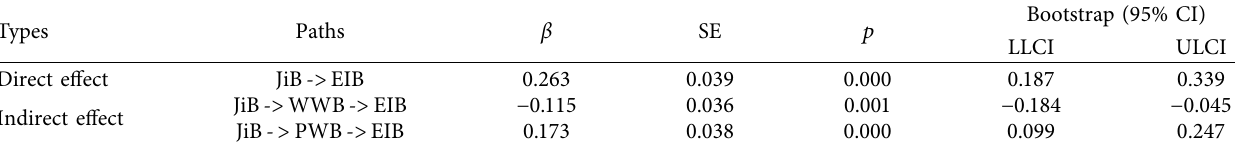
Table 5: Analysis on the mediating effect of proactive work behavior and working withdrawal behavior ( N � 665).